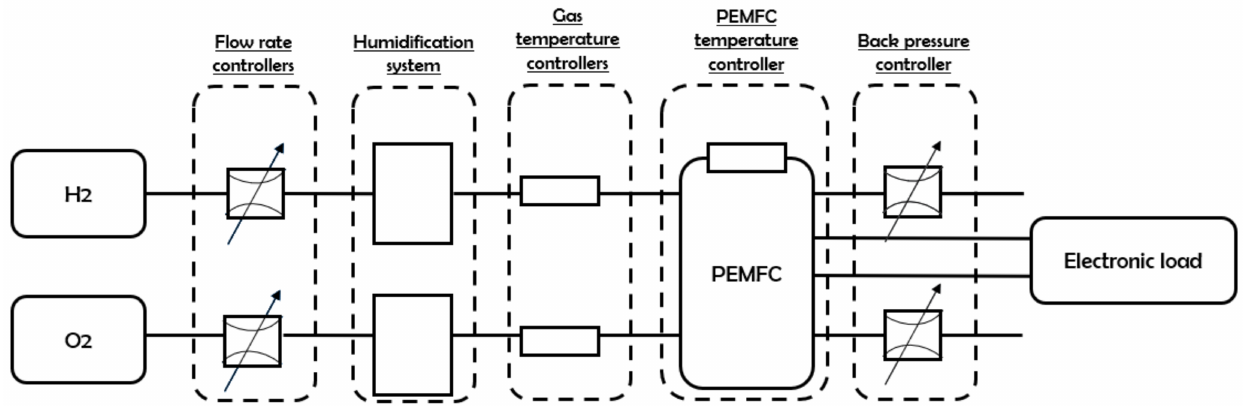
Figure 4. Example of humidified system synoptic of a